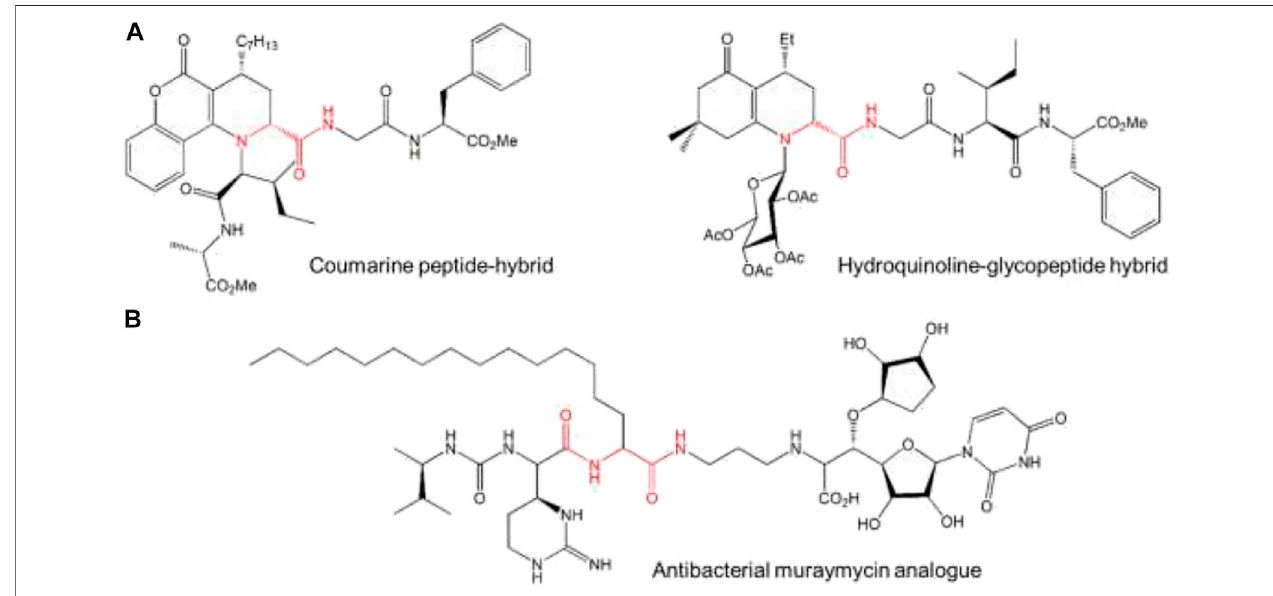
FIGURE 10 | Peptide-peptide and carbohydrate peptide conjugation. (A) The fi nal product of diastereoselective multicomponent ligation (MCL) of peptide and sugar residues to chiral bifunctional building blocks, (B) fi nal product of MLC of urea-peptide, a lipid, and aminoribosyl-5-C-glycyludrine. The most important covalent bond between entities is highlighted in red.